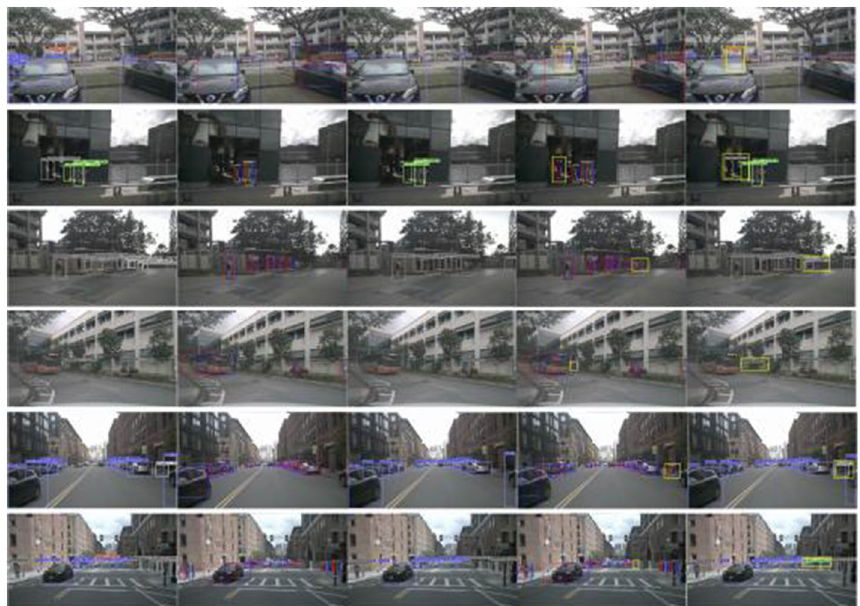
Fig. 6 Experimental effect of missed detection compared with the baseline model is plotted.The first column is the estimated depth value on the image, which can visualize the specific target on the image and facilitate the experimental comparison effect demonstration; the second column is the 3D block diagram of the target detected by the baseline model; the third column is the specific classification and detection effect